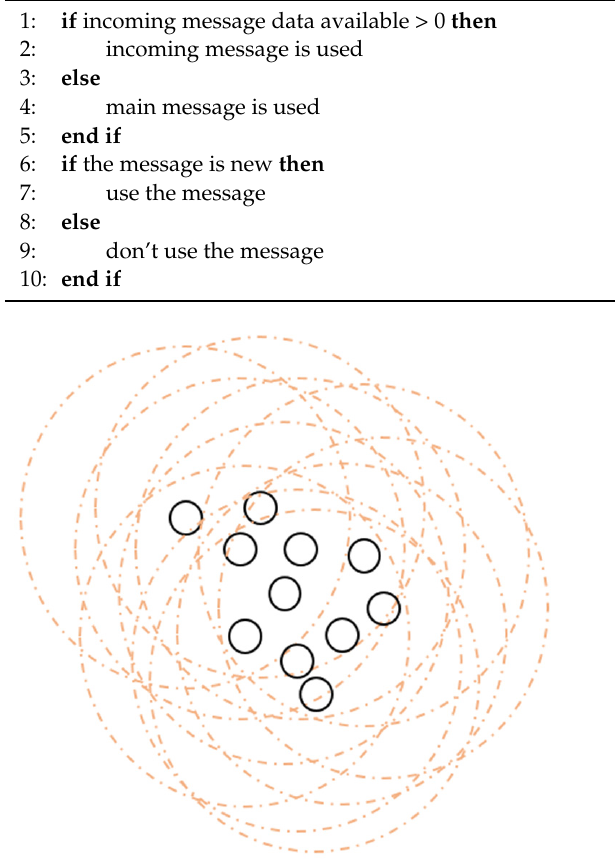
Figure 13. Keeping communication ranges long. Algorithm 7 Solution: Communication distance is too high